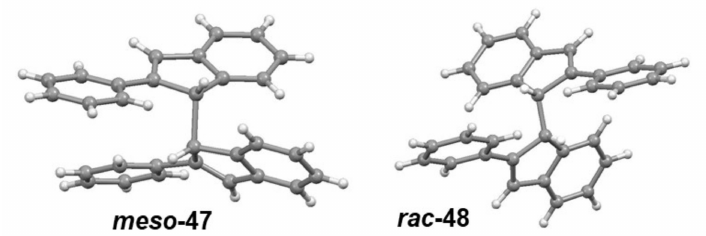
Figure 23. Molecular structures of meso - and rac -2,2 (cid:48) -diphenyl-1,1 (cid:48) -biindenyl, 47 and 48 .